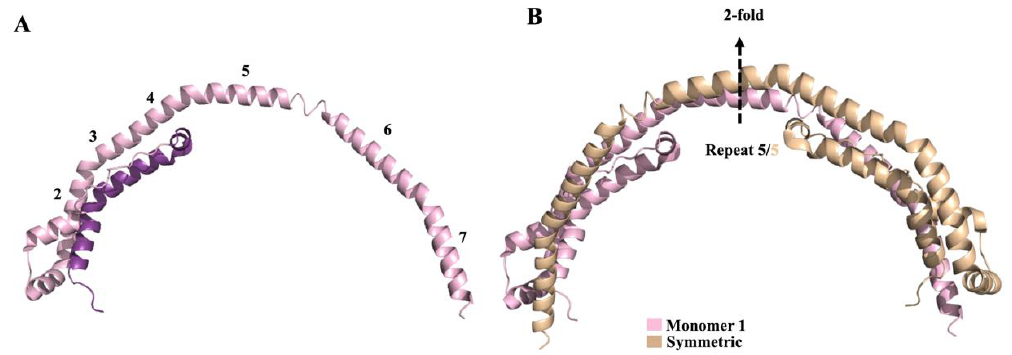
Figure 7. Graphic representation of ∆ (185–243)apoA-I crystal structure (PDB code 3R2P). ( A ) Monomer of ∆ (185–243)apoA-I. N -terminus 3-43 residues are colored in violet, 44-184 ligthpink. Helix repeats 1-7 are reported. ( B ) Homodimer representation of ∆ (185–243)apoA-I. The crystallographic 2-fold axis crossed the middle of sequence repeat 5.